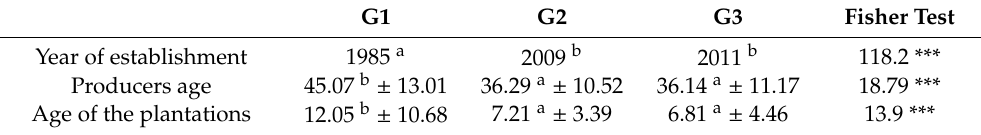
Table 7. Summary of qualitative variables characteristic of the profile of infiltrators and cocoa plantations. G1 G2 G3 1985